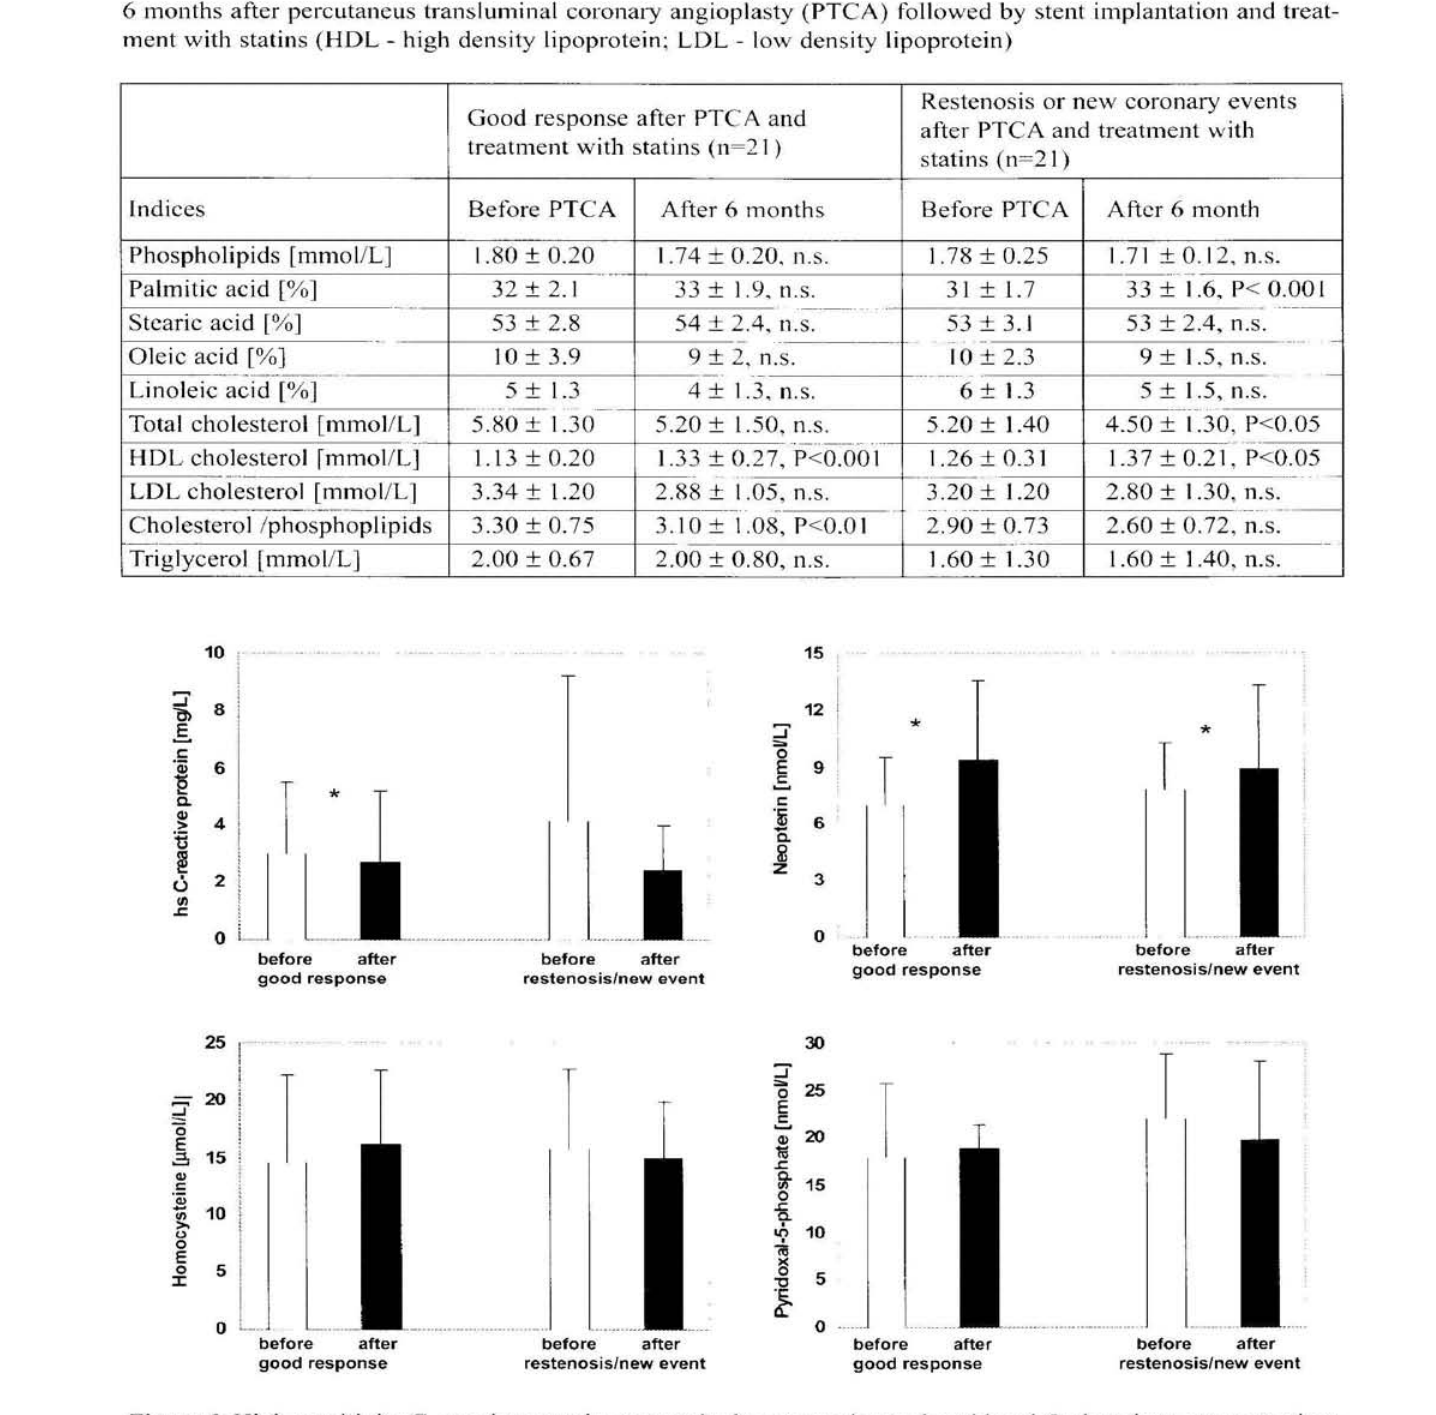
Figure I. High sensitivity C-reactive protein, neopterin, homocysteine and pyridoxal-5-phosphate concentrations in sera of patients with coronary artery disease before (white columns) and 6 months after (black columns) per- cutaneus transluminal coronary angioplasty followed by stent implantation and treatment with statins; left part shows results obtained in patients with good response to therapy, right part shows patients with restenosis or new events during 6 months of follow-up. Mean values ± S.D. are shown, *p<0.05 (paired test)